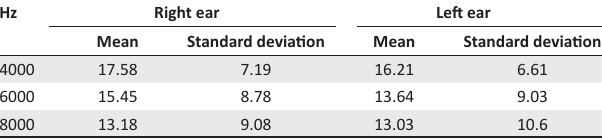
TABLE 3: Mean hearing thresholds of instrument players only ( n = 31) at 4.6 kHz and 8 kHz. Hz